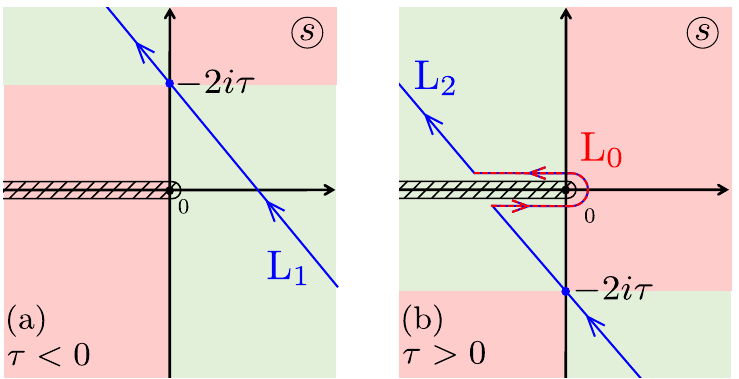
Figure 2. Contours of integration L 1,2 in Eq. (11) as used in Ref. 1 . The regions where the saddle point method could be applied are shown in green. The contour L 1 in ( a ) corresponds to τ < 0 , and L 2 in ( b ) corresponds to τ > 0 . The contour L 0 is a part of the contour L 2 , which is partly situated in the pink region. The integration along this contour should be calculated separately from the integral calculated within the saddle-point method, both of which contribute to the integral in Eq.